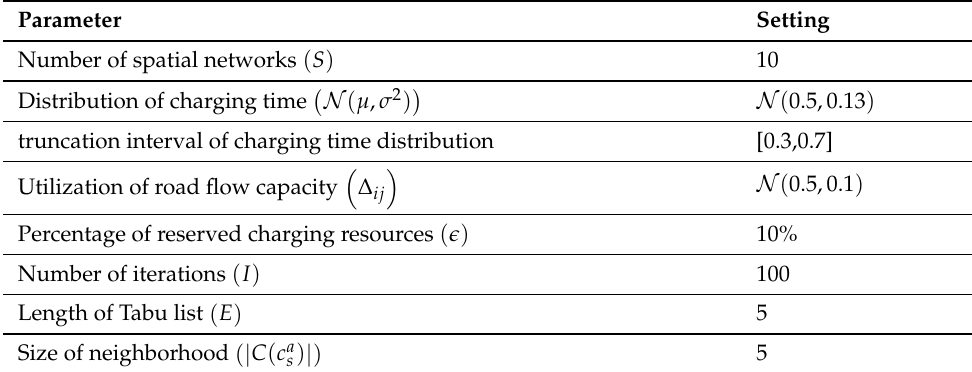
Table 3. Parameters of